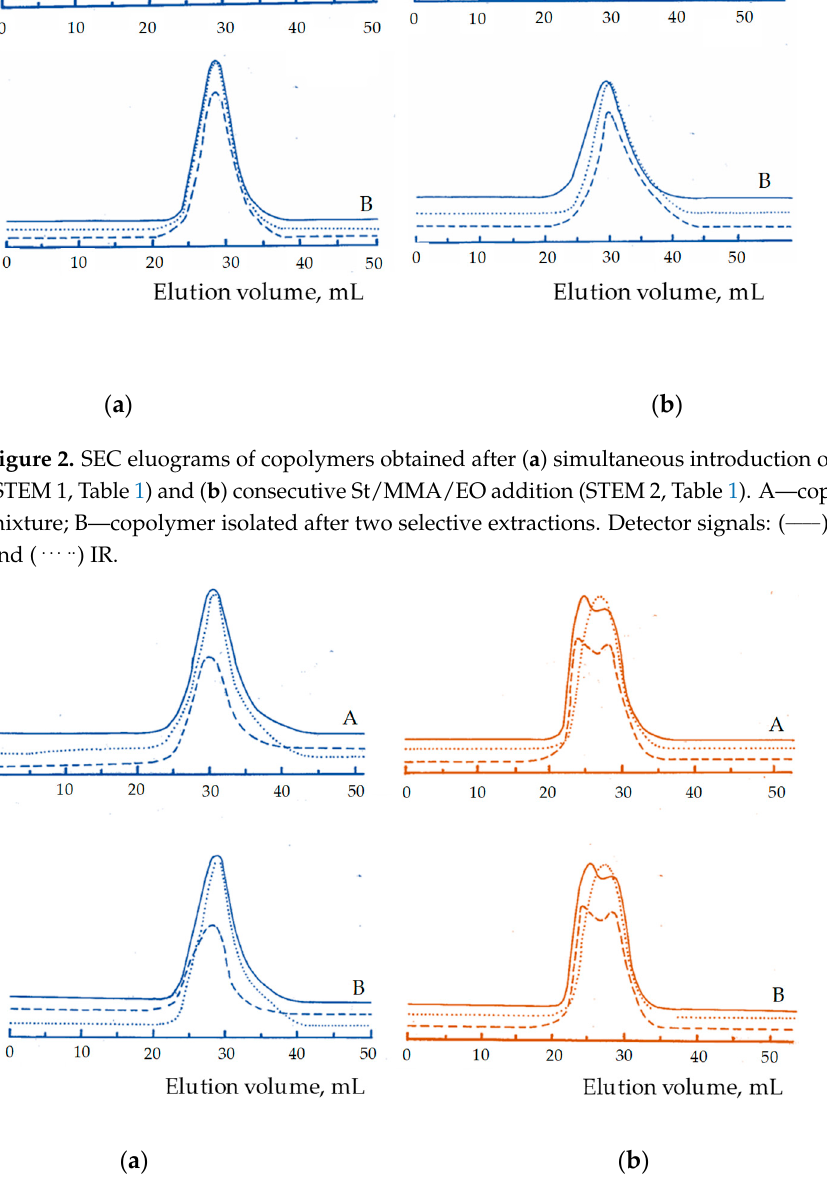
Figure 3. SEC eluograms of copolymers obtained after ( a ) consecutive St/MMA/EO addition in p-xylene (STEM 3, Table 1) and ( b ) consecutive EO/St/MMA addition in bulk. A—copolymerization mixture; B—copolymer isolated after two selective extractions. Detector signals: ( ____ ) dRI, (- - -) UV and ( ….. ) IR.